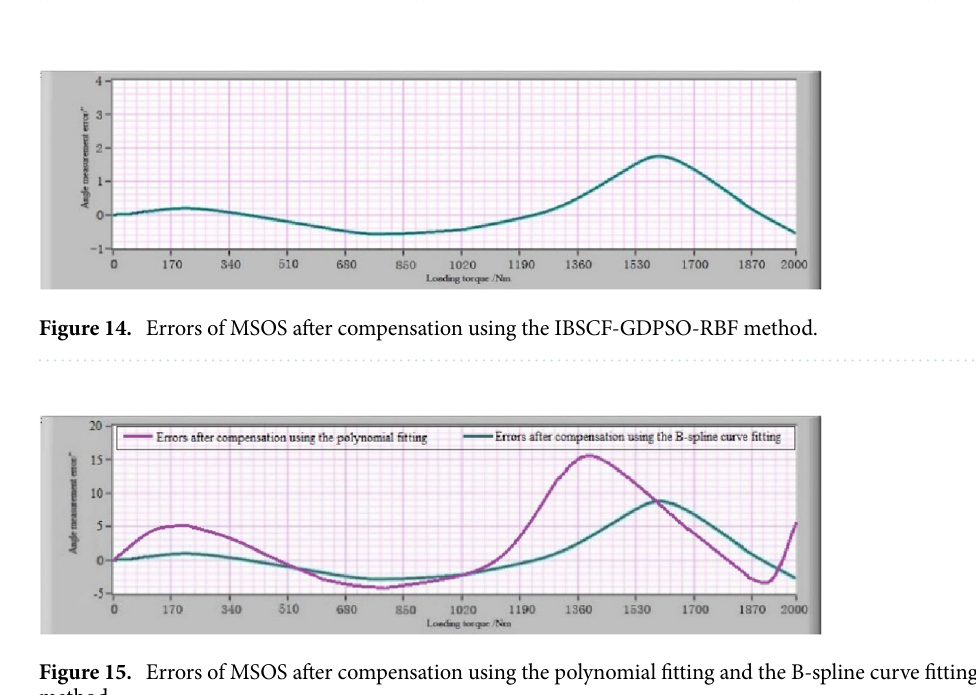
Figure 13. Errors of MSIS after compensation using the IBSCF-GDPSO-RBF method.